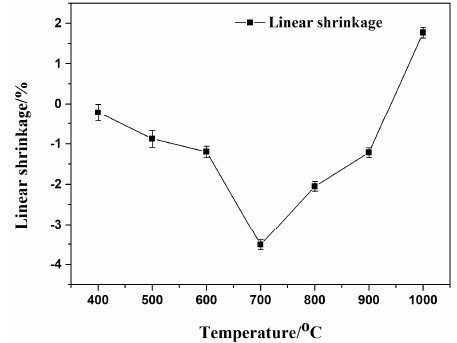
Figure 11. The linear shrinkage of the EVA composites at different sintering temperature.